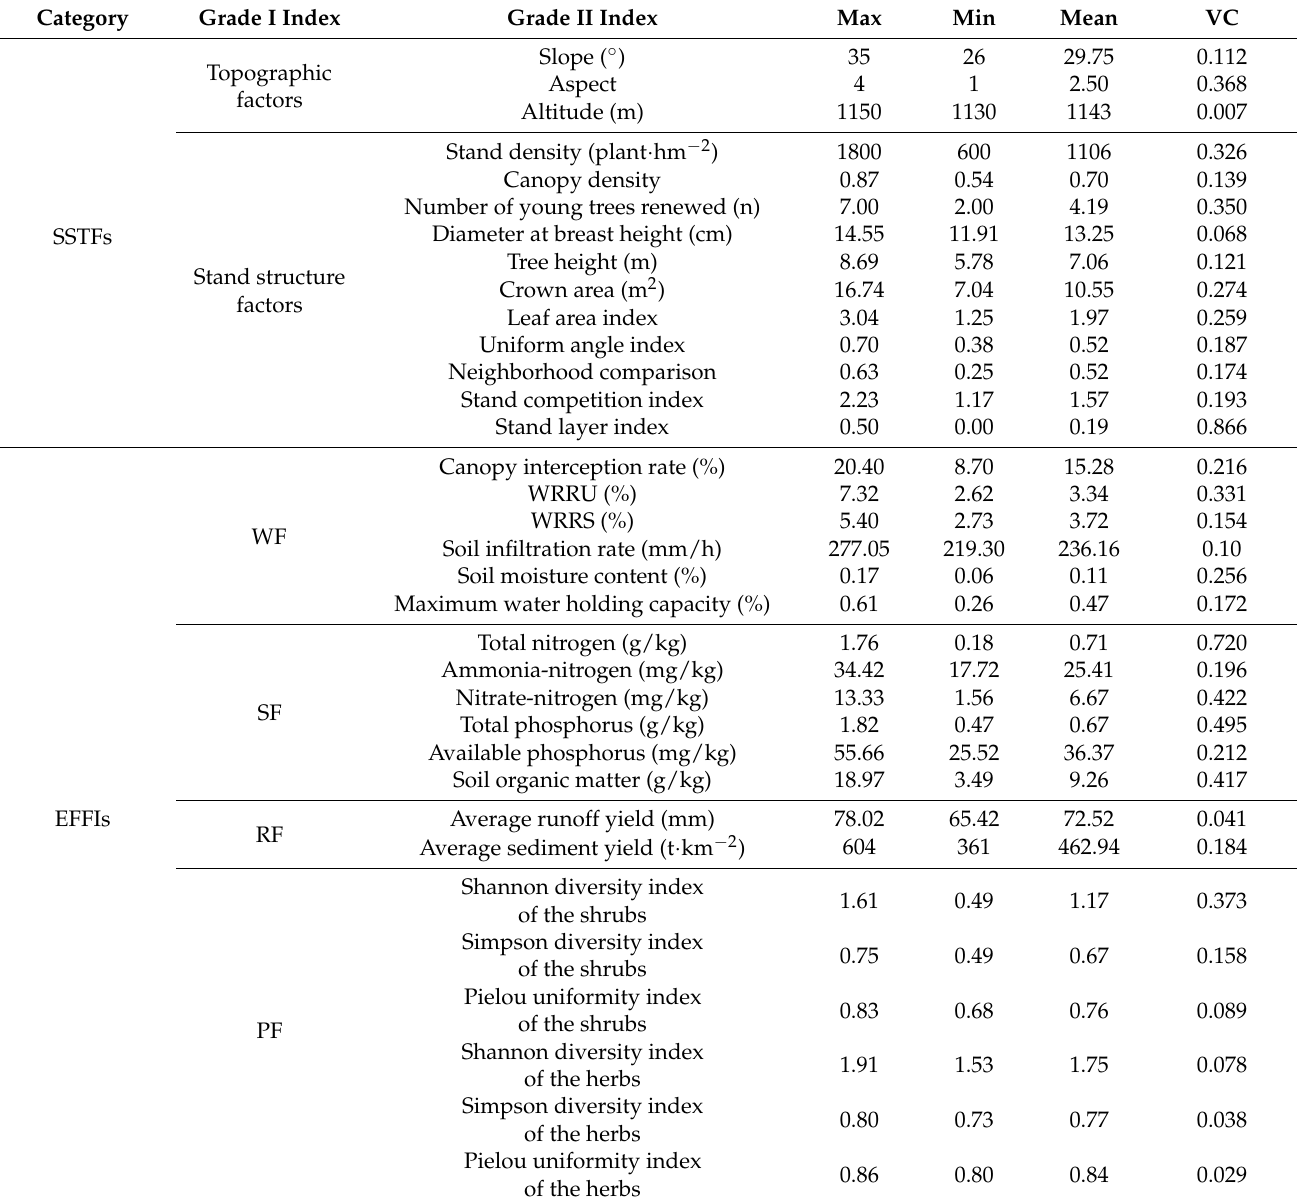
Abbreviations: SSTFs, stand structure and topographical factors; EFFIs, functional indices of ecological function; VC, variable coefficient; WF, water-holding function; SF, soil improvement function; RF, function of reducing runoff and sediment yield on slope; PF, diversity function of the understory plants; WRRU, water retention rate of the litter in the undecomposed layer; and WRRS, water retention rate of the litter in the semi-decomposed